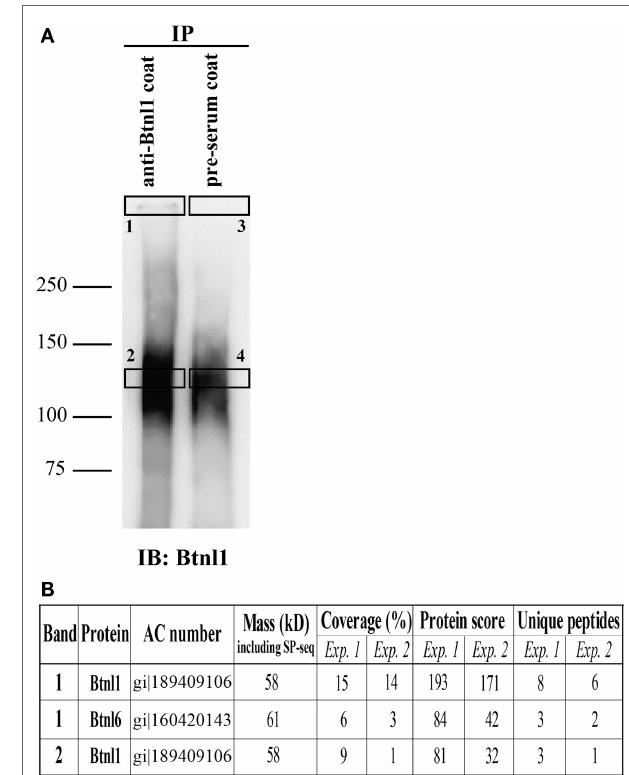
FigUre 4 | Btnl1 and Btnl6 form heteromeric interactions in primary small intestinal epithelial cells. Lysate from isolated primary intestinal epithelial cells were immunoprecipitated with anti-Btnl1 or preimmune rabbit serum-coated beads. Bound protein was released from the beads using alkaline conditions and separated by SDS-PAGE under non-reducing conditions. (a) Separated eluates after immunoblot with anti-Btnl1 antibody followed by HRP-conjugated anti-rabbit antibody. The unspecific band in the preimmune serum lane indicates that some bead-coupled antibodies were released in the elution step. Squares (1–4) indicate excised bands on a corresponding Coomassie stained gel subjected to in-gel digestion by trypsin followed by mass spectrometry analysis. (B) The table shows identified butyrophilin-like proteins in corresponding excised bands in the two independent experiments performed. Neither Btnl1 nor Btnl6 was detected in samples immunoprecipitated with preimmune serum (band 3 and 4). Data are representative of two independent experiments. AC, accession number; SP, signal peptide. A complete list of identified proteins in the excised gel bands is given in Table S1 in Supplementary Material.